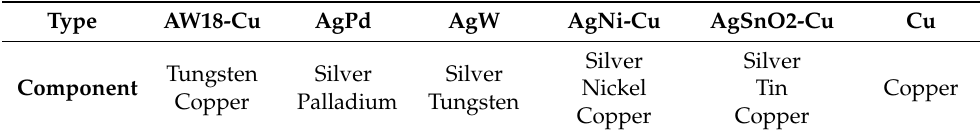
Table 1. Five kinds of contact materials of the DC switch experiment.